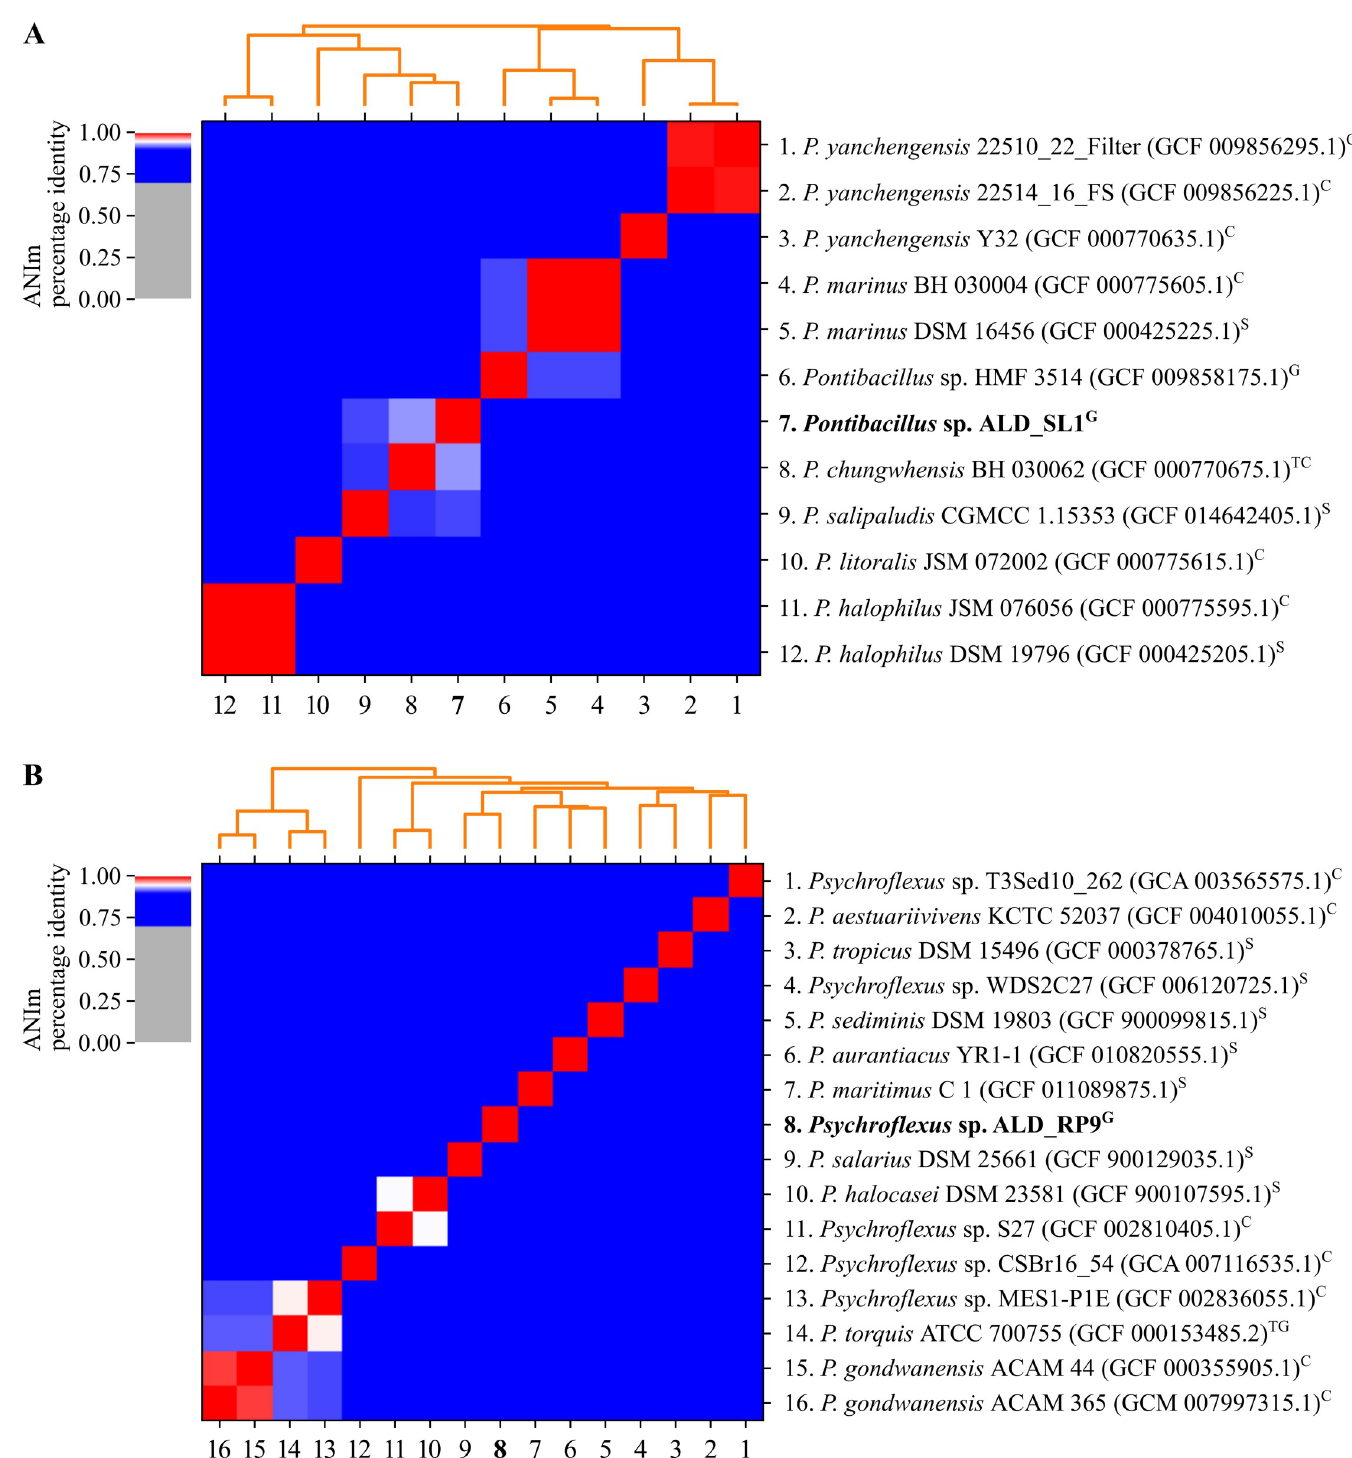
Fig 4. Relatedness of Pontibacillus (A) and Psychroflexus (B) genomes. All available genome assemblies of each genus were aligned and compared using ANIm in pyANI v0.2.10. [31]. The level of genome completeness is indicated in upper case: contig (C), scaffold (S), full genome (G), genus type species (T).